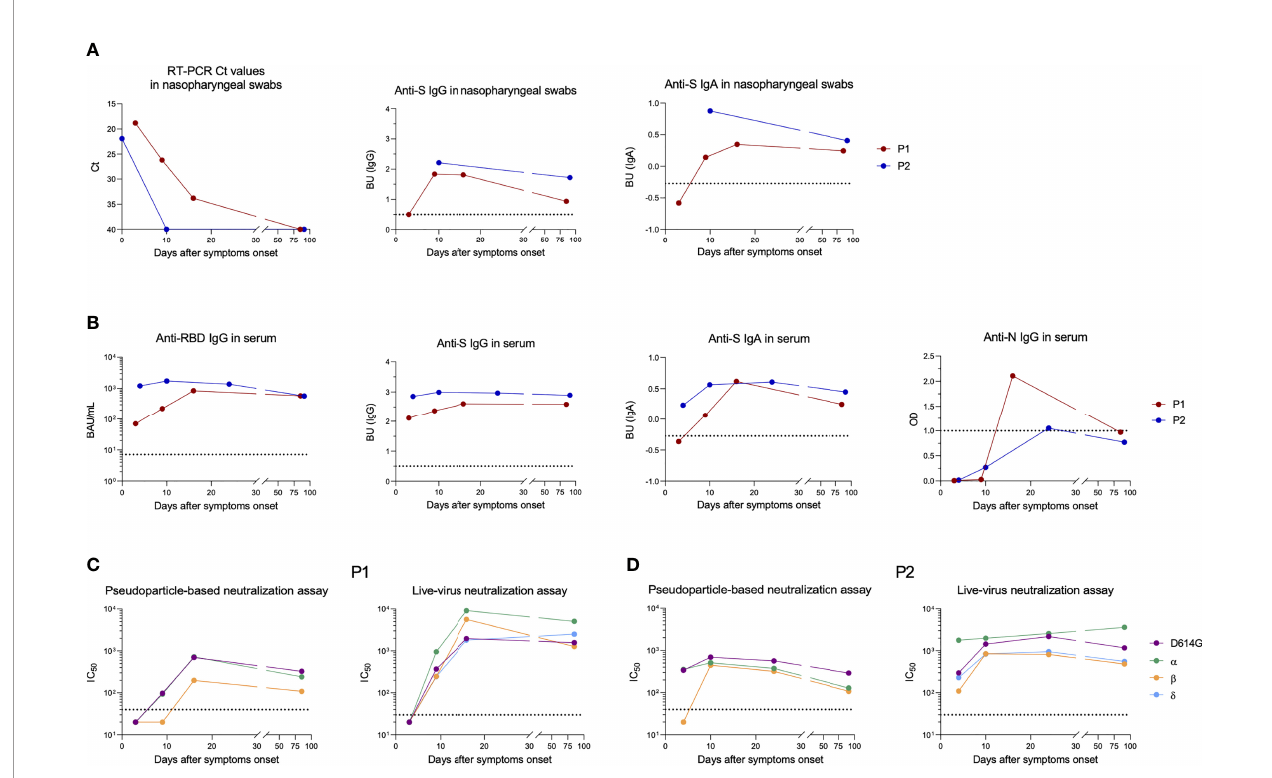
FIGURE 1 | Longitudinal follow-up of anti-SARS-CoV-2 humoral response after breakthrough infection in patient 1 (P1) and patient 2 (P2). (A) Viral shedding and antibodies detected against the SARS-CoV-2 spike (S) protein in nasopharyngeal swabs from P1 (red dots) and P2 (blue dots). Ct values are depicted on the fi rst graph (left) and anti-S IgA and IgG levels on the two other graphs. to the positivity threshold. (B) Antibodies directed against SARS-CoV-2 receptor binding domain (RBD), S or nucleocapsid (N) proteins measured in serum from P1 (red dots) and P2 (blue dots). (C, D) Half-maximal inhibitory concentration (IC 50 ) measured in P1 (C) and P2 (D) by pseudoparticle-based (left) and live-virus neutralization (right) assays against several SARS-CoV-2 variants. Sera displaying less than 50% luminometric signal reduction relative to the control condition with the fi rst serum dilution tested (1:40 and 1:30 with pseudoparticle-based and live-virus neutralization assays, respectively) were considered negative and depicted on graphs with an IC 50 set arbitrarily at 20. The dotted horizontal black lines correspond to positivity thresholds. BAU, Binding Antibody Units; BU, binding units; Ct, Cycle